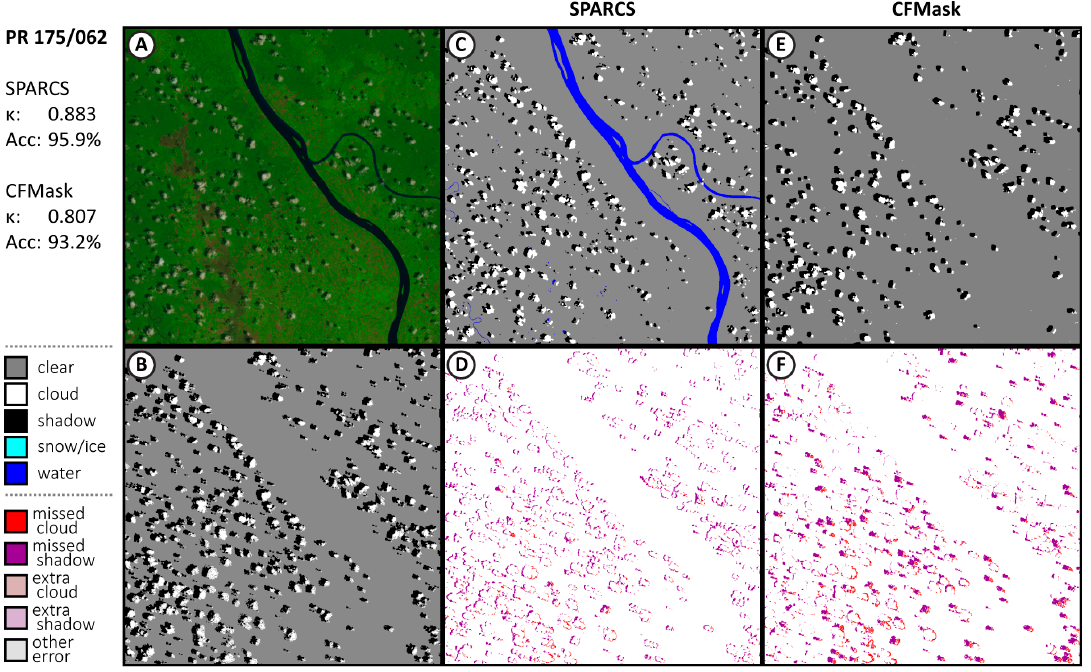
Figure A9. Results for Biome test image from PR 175/062, with false color image used during interpretation (A), the manually labeled interpretation (B), generated masks from SPARCS (C) and CFMask (E), and respective spatial distribution of errors (D, F).